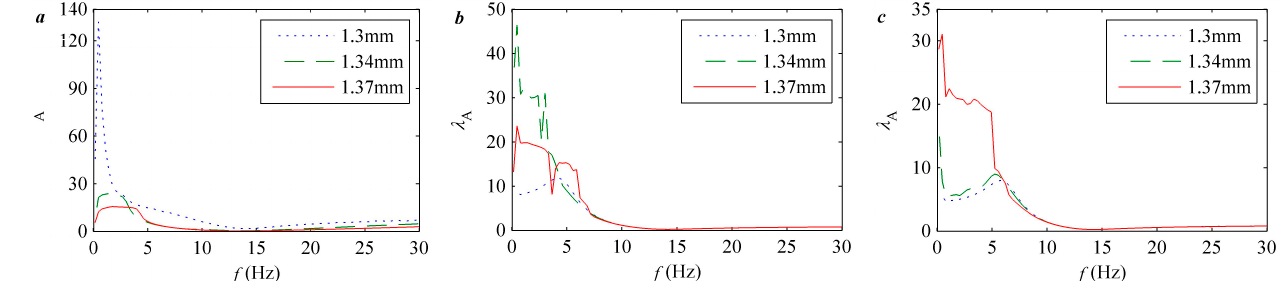
Figure 9. The simulated results with applied voltages of ( a ) 10 V, ( b ) 100 V, and ( c ) 200 V for pretensions of 1.30 mm (dot), 1.34 mm (dashed), and 1.37 mm